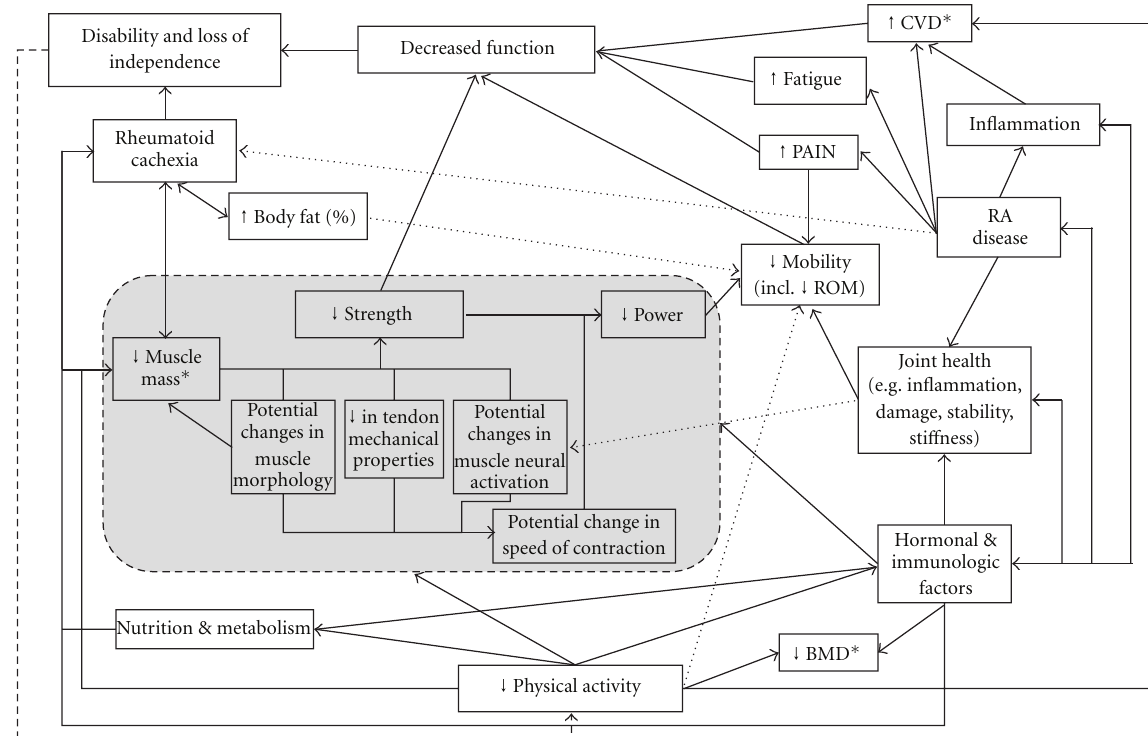
Figure 1: A summary of the influence of skeletal muscle properties on the factors a ff ecting functional limitation, disability and loss of independence in RA. Note: not all of the skeletal muscle properties have been routinely demonstrated with RA (e.g., [60, 61]). BMD: bone mineral density, CVD: cardiovascular disease, ROM: range of motion. ∗ Factors that are adversely a ff ected by